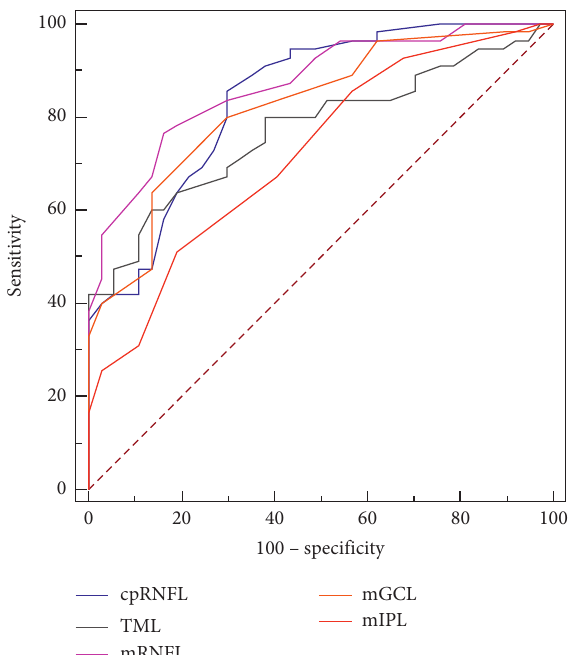
Figure 1: AROC curves of thicknesses of cpRNFL, TML, mRNFL, mGCL, and mIPL for discriminating highly myopic normal-tension glaucoma from highly myopic control subjects. AROC: areas under the receiver operating characteristic. cpRNFL: circumpapillary retinal nerve fiber layer thickness. TML: total macular layer thickness. mRNFL: macular retinal nerve fiber layer thickness. mGCL: macular ganglion cell layer thickness. mIPL: macular inner plexiform layer thickness.